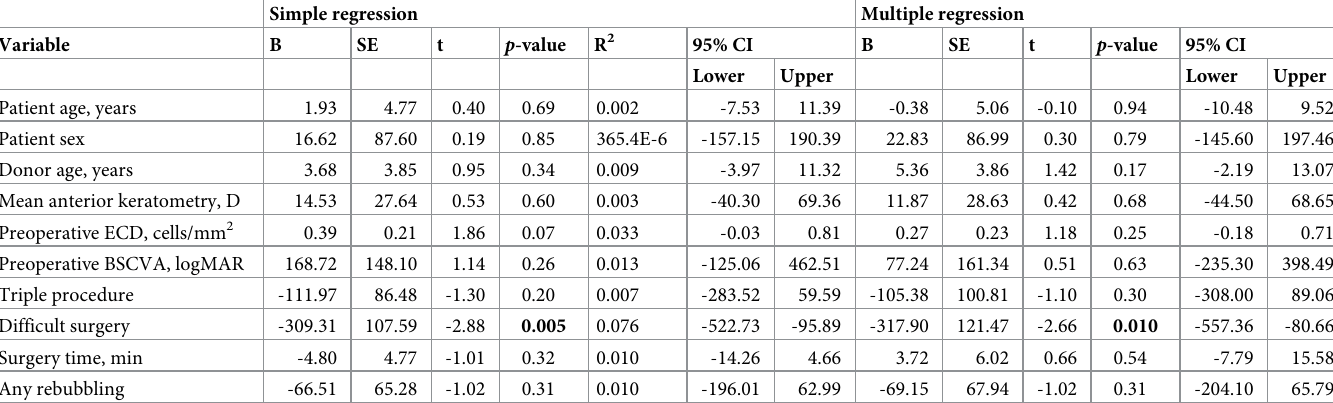
Table 2. Simple and multiple linear regression analysis of the relationship between endothelial cell density at 6 postoperative months and preoperative patient or graft or operative variables. Simple regression Multiple regression